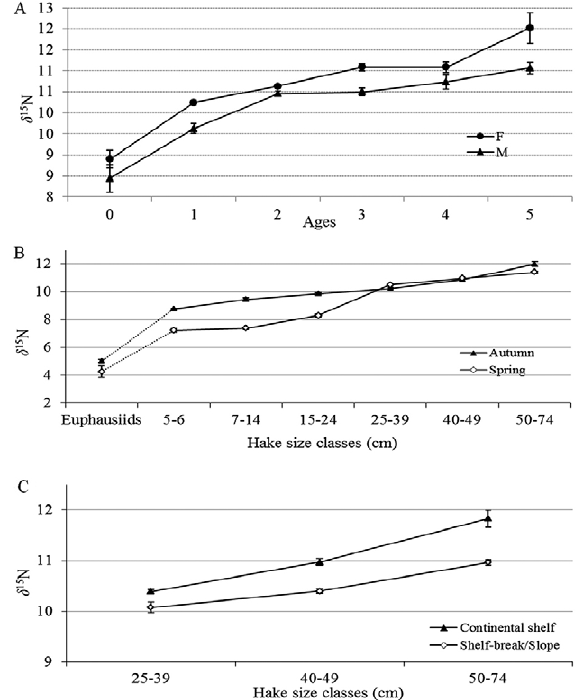
Fig. 8. – Ontogenetic δ 15 N changes of hake with (A) sex (F, female; M, male), (B) season ( δ 15 N Euphausiids = baseline) and (C)